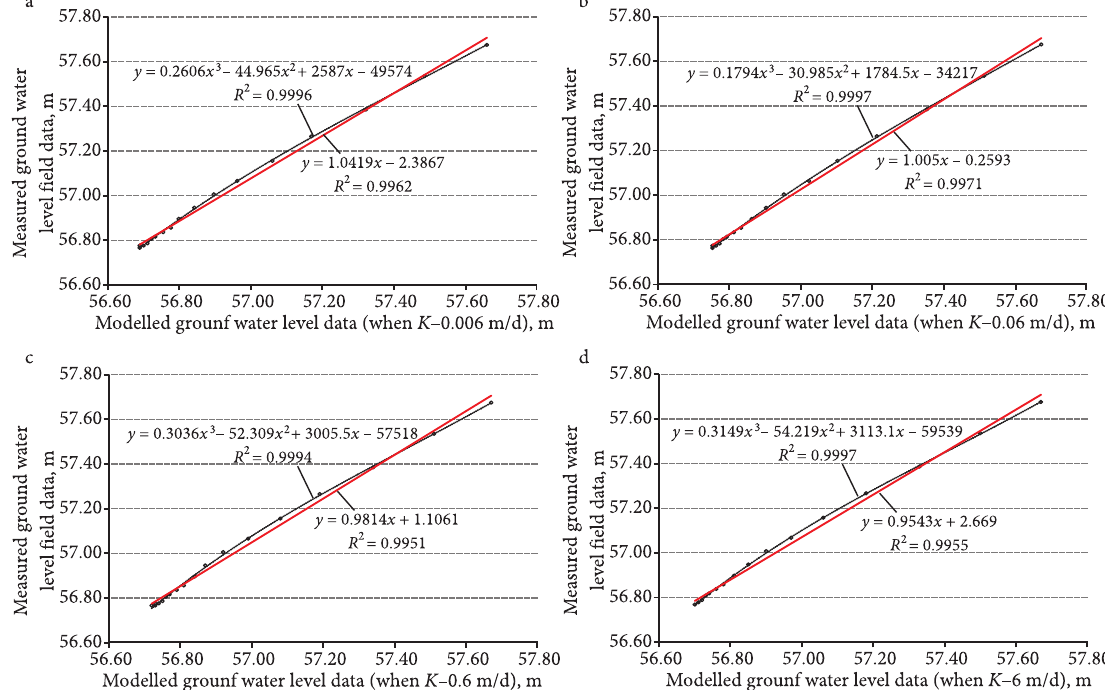
Fig. 5. Impact of the modelled cross drains on the water table depression in the area drained when the space between trenches is 30 m